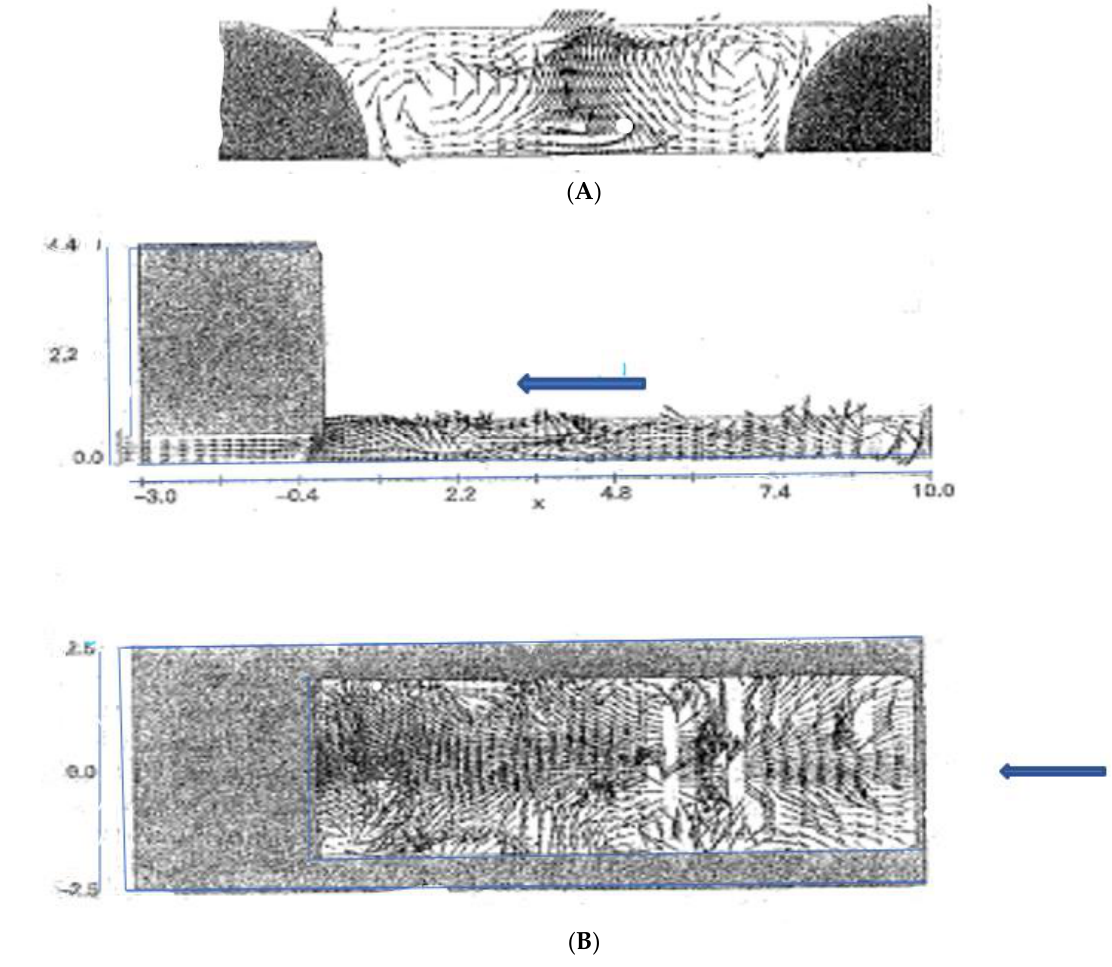
Figure 63. ( A ) Front view of flow velocity vectors prior to the back wall opening; Ref. [1], p. 336. ( B ) CFD midpoint side view ( top figure ) and top view ( bottom figure ) velocity vectors; Ref. [1], p. 335. Figures indicate a high creation level of water vortical structures and turbulence before the wall opening. Arrow represents flow direction. Scale in Av meters.